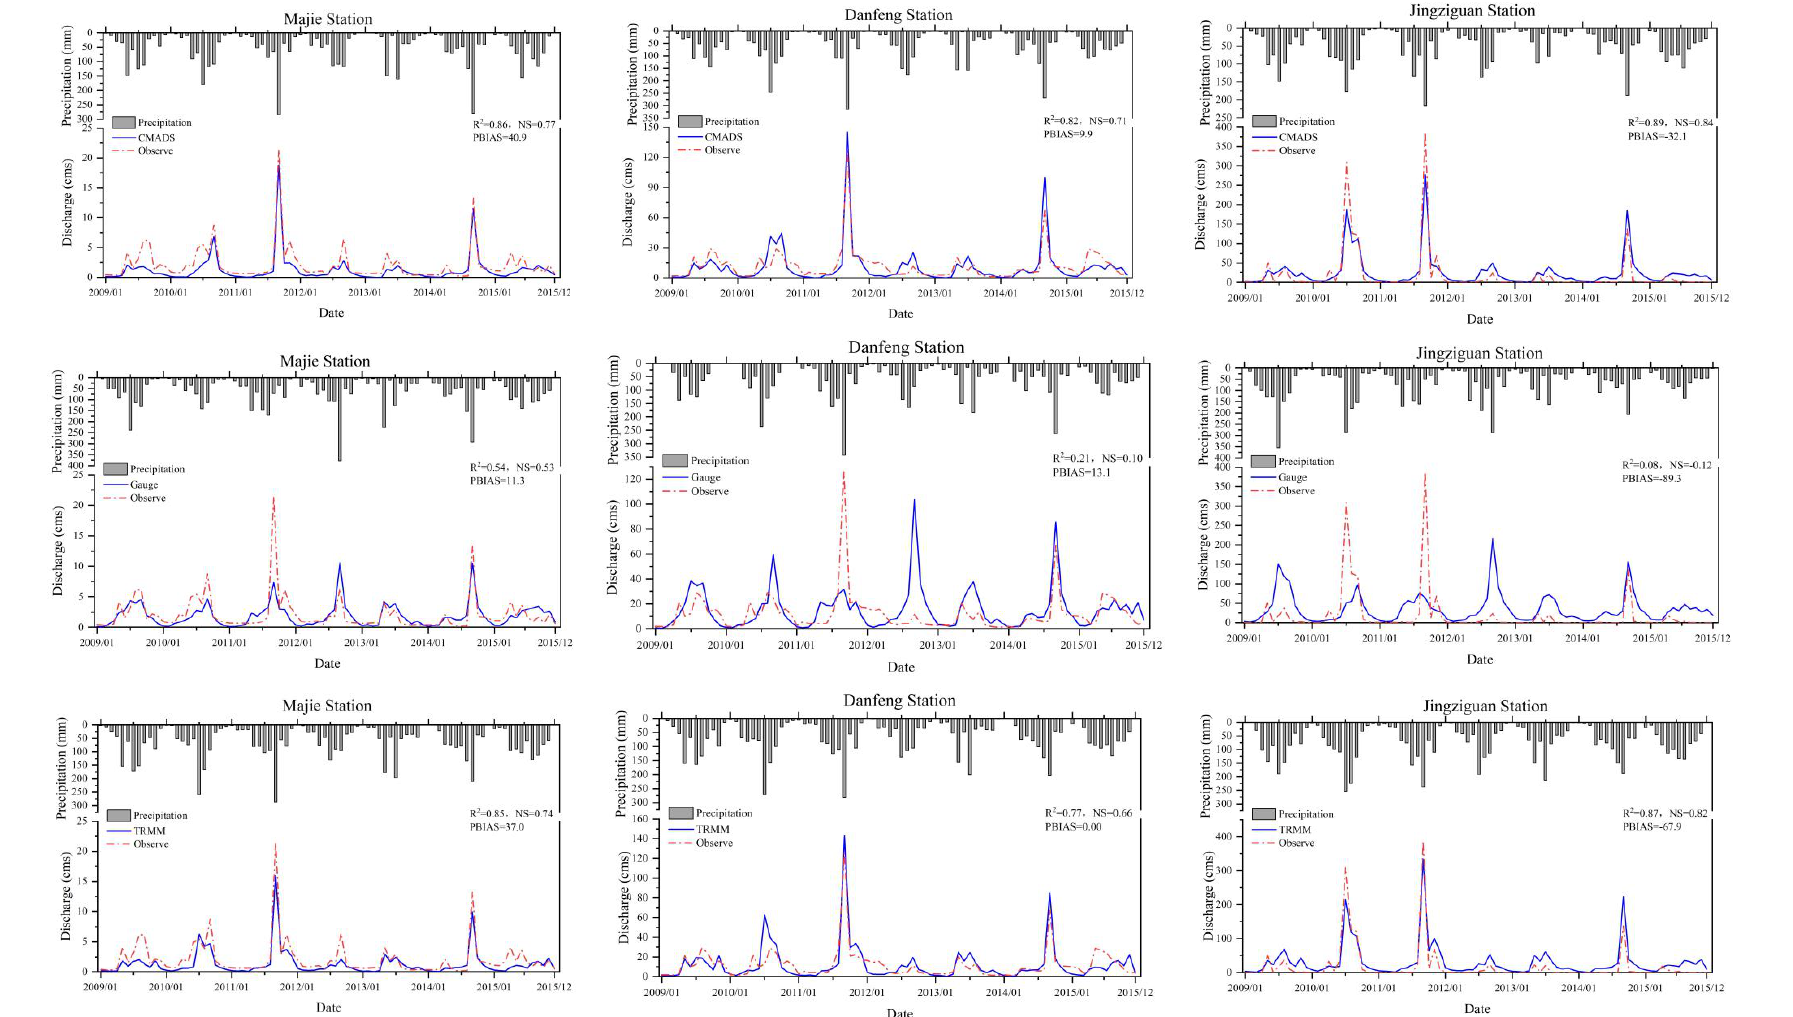
Figure 8. Observed and simulated discharges at Majie Station, Danfeng Station, and Jingziguan Station in the DRB at a monthly scale using inputs from Gauge, CMADS, and TRMM. Note that this figure is given as year/month.